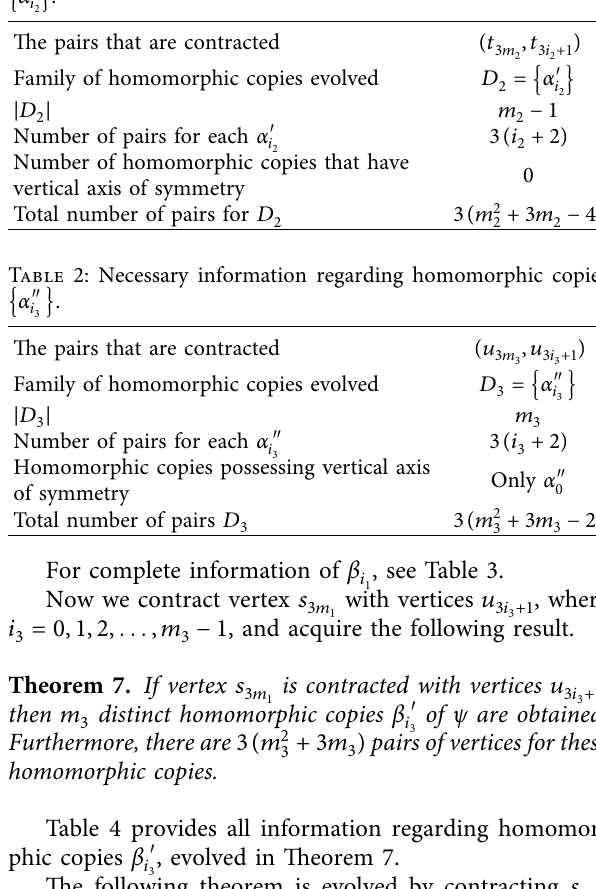
Table 3: Necessary information regarding homomorphic copies